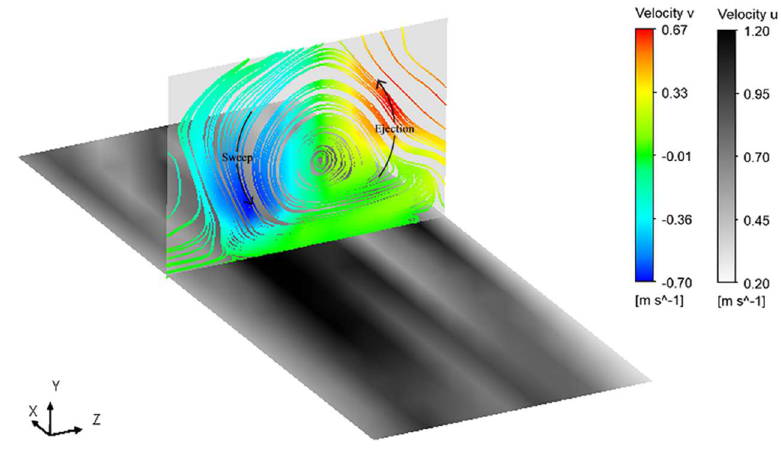
Figure 8. Connection between the streaks and the streamwise vortex. The sweep event increases the velocity near the wall, causing the high-speed streak, while the ejection decreases the velocity, causing the low-speed streak.